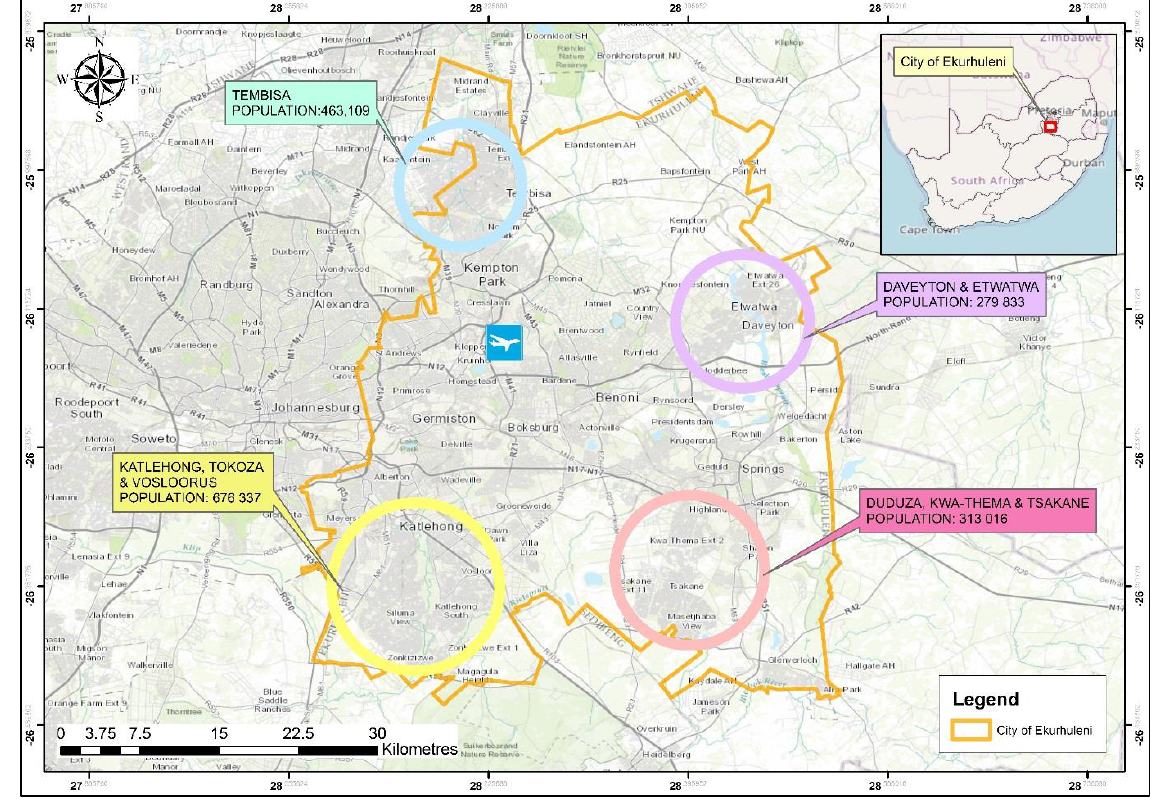
Figure 1: Location of Townships in City of